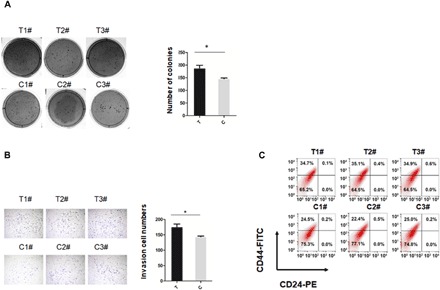
SNP rs55958994 is a functional SNP in 22Rv1 cells.(A) Soft agar colony formation assays comparing WT 22Rv1 cells with (C) allele of rs55958994 and 22Rv1 cells with (T) allele of rs55958994. Quantification is at right. Data represent means ± SEM of three independent experiments. *P < 0.05. (B) Transwell assays in WT 22Rv1 cells with (C) allele of rs55958994 and 22Rv1 cells with (T) allele of rs55958994. Cells that had migrated to lower chambers were stained with 0.1% crystal violet. Quantification is at right. Data represent means ± SEM of three independent experiments. *P < 0.05. (C) FACS analysis of the cell surface markers CD44 and CD24 in WT 22Rv1 cells with (C) allele of rs55958994 and in 22Rv1 cells with (T) allele of rs55958994.